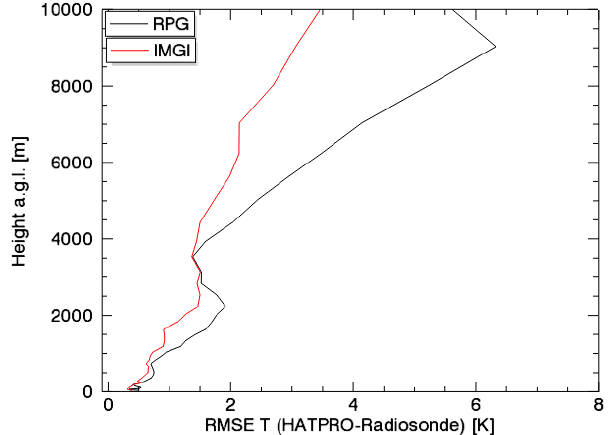
Figure 4. Same as Fig. 3, but for absolute humidity.